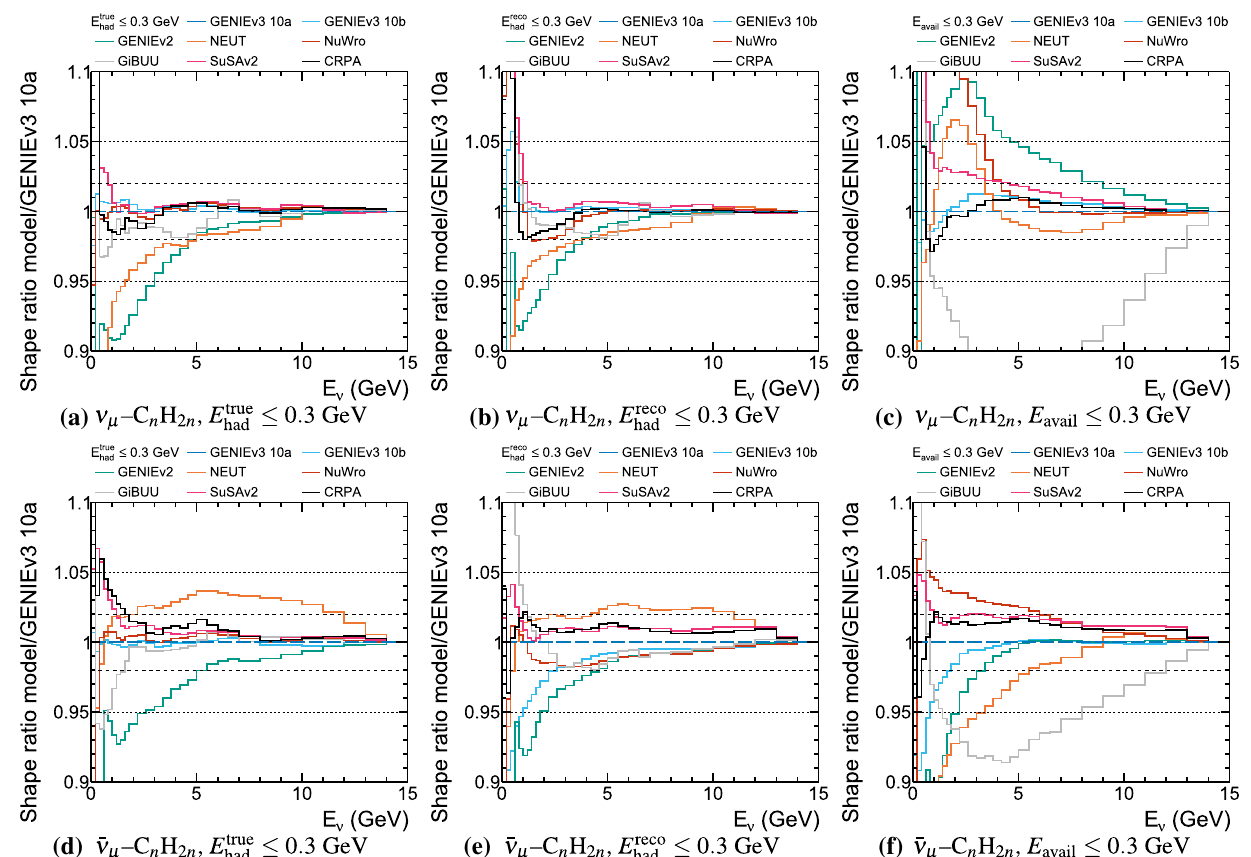
duced using the flat neutrino flux described in Sect. 4. Horizontal long (short) dashed lines have been added at ± 2% ( ± 5%), to guide the eye in assessing the scale of the